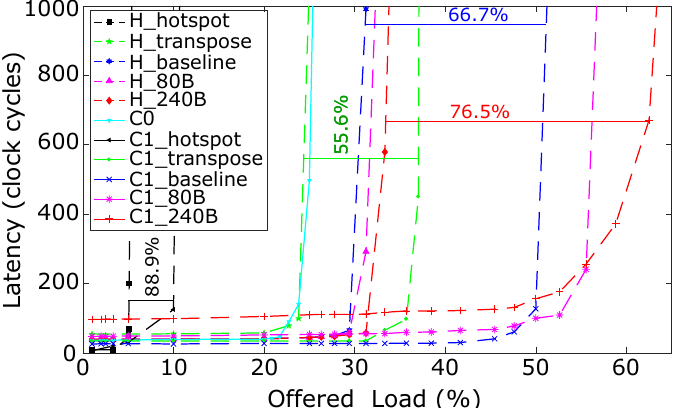
Figure 14. Performance comparison for R-NoC and Hermes routers. XB denotes baseline router with additional X buffers.